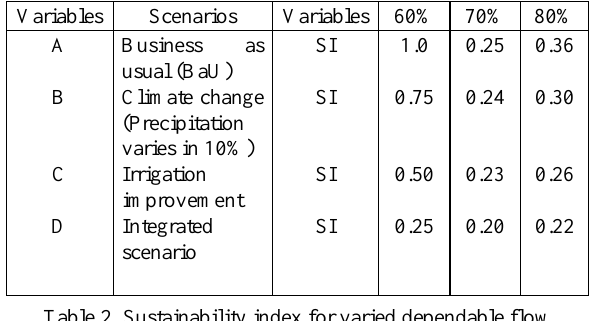
Table 2. Sustainability index for varied dependable flow